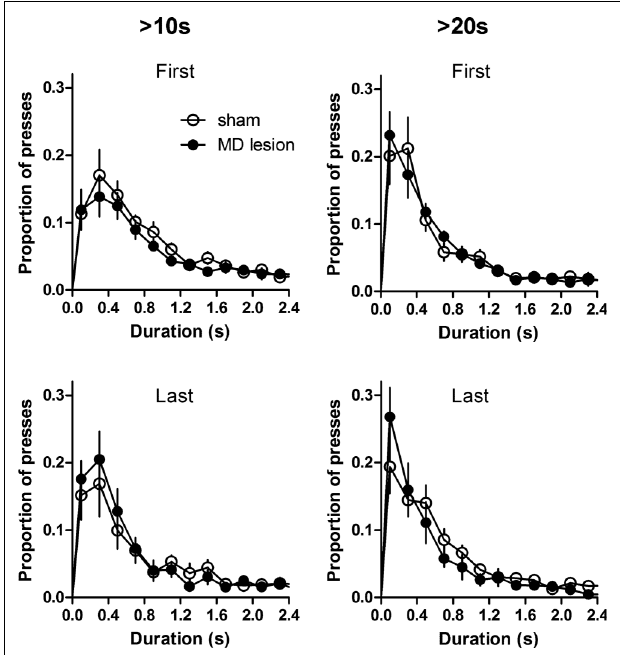
FIGURE 6 | The distribution of lever press durations during the fi rst and last sessions for each criterion IRT: Duration distribution was not affected by MD lesions when press duration is not the differentially reinforced operant. Thus, rather than having a general effect on lever press duration, MD lesions only impaired the differentiation of press duration. Error bar represents